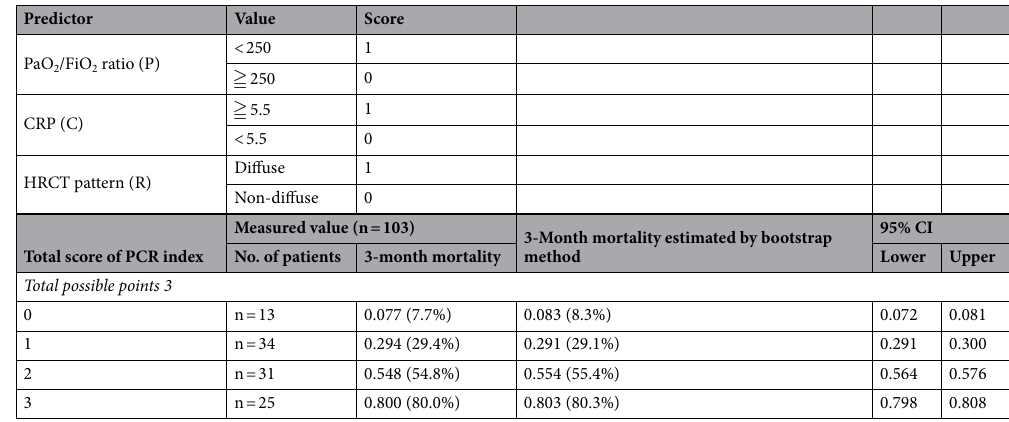
Predictor Value